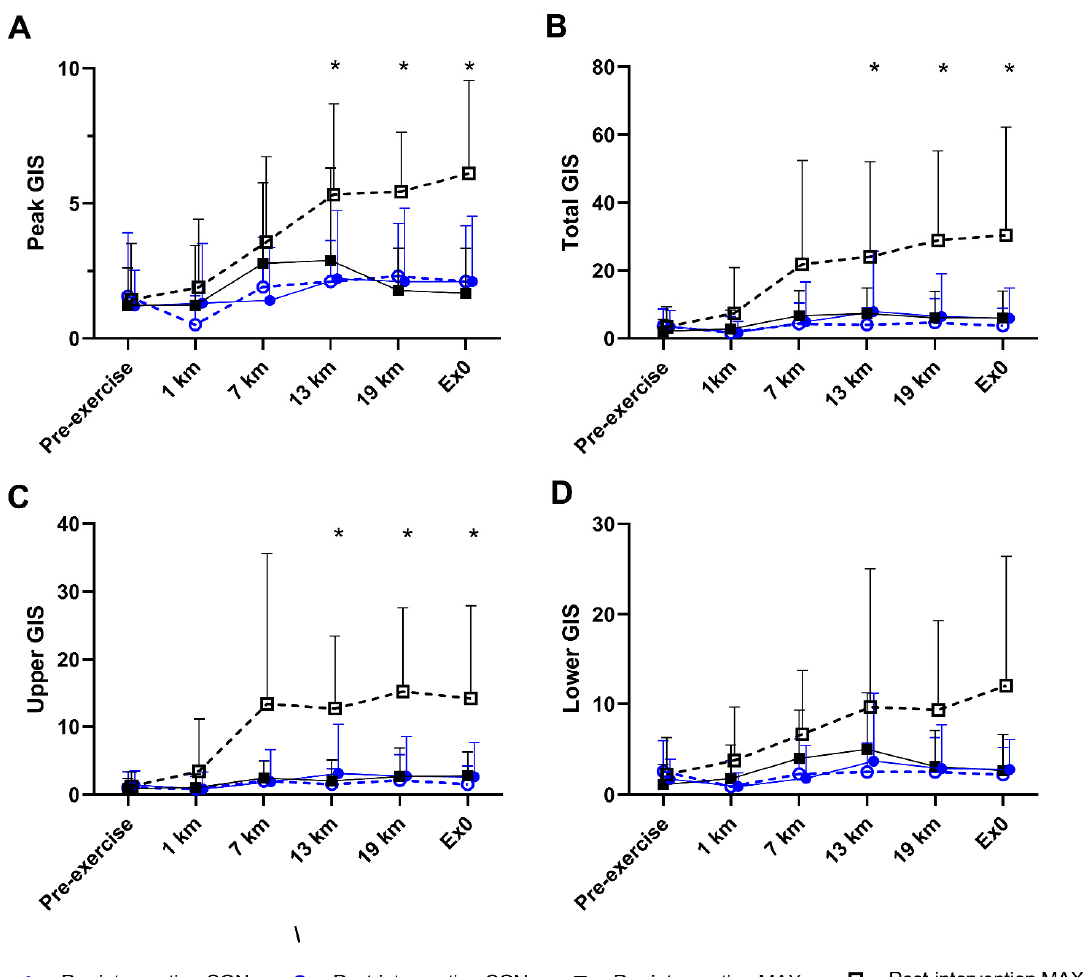
Figure 3. ( A ) Peak, ( B ) total- ( C ) upper-, and ( D ) lower-GIS during a 26 km race walking protocol in elite race walkers before (pre-intervention) and after (post-intervention) a protocol to increase endogenous and exogenous CHO availability (MAX) compared with a control condition (CON) involving moderate CHO availability. Data are presented as mean and standard deviation of summative accumulation of respective GIS category. * = significant difference between the CON and MAX groups.